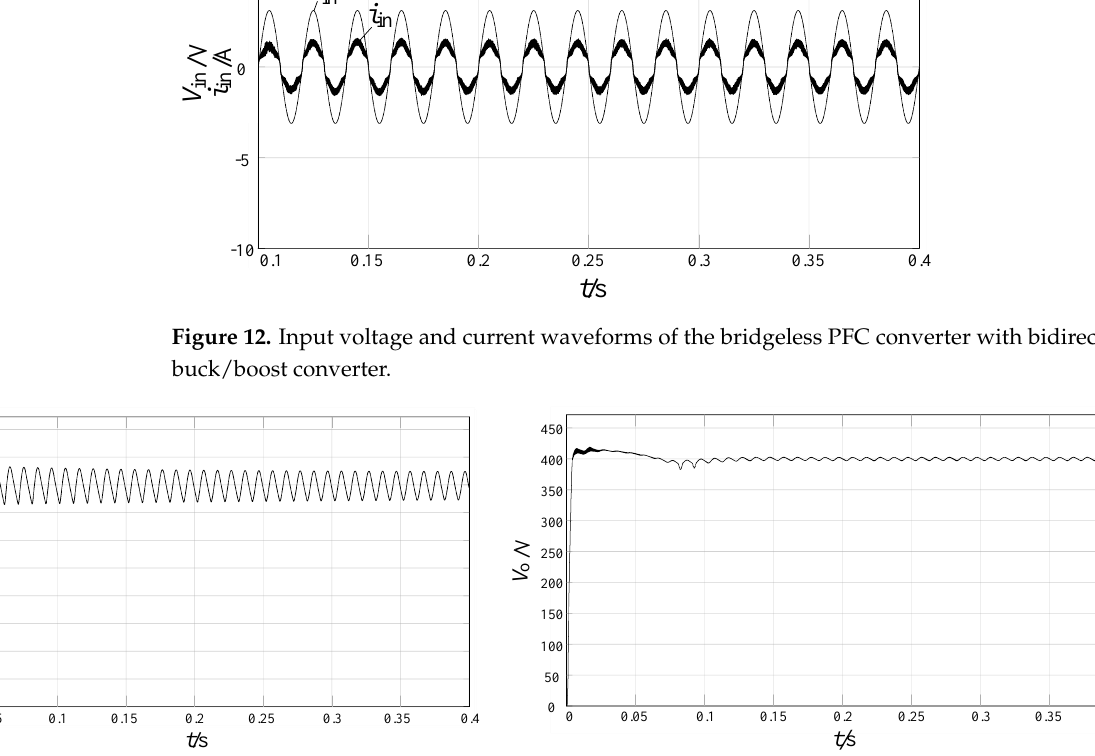
Figure 12. Input voltage and current waveforms of the bridgeless PFC converter with bidirectional buck/boost converter.